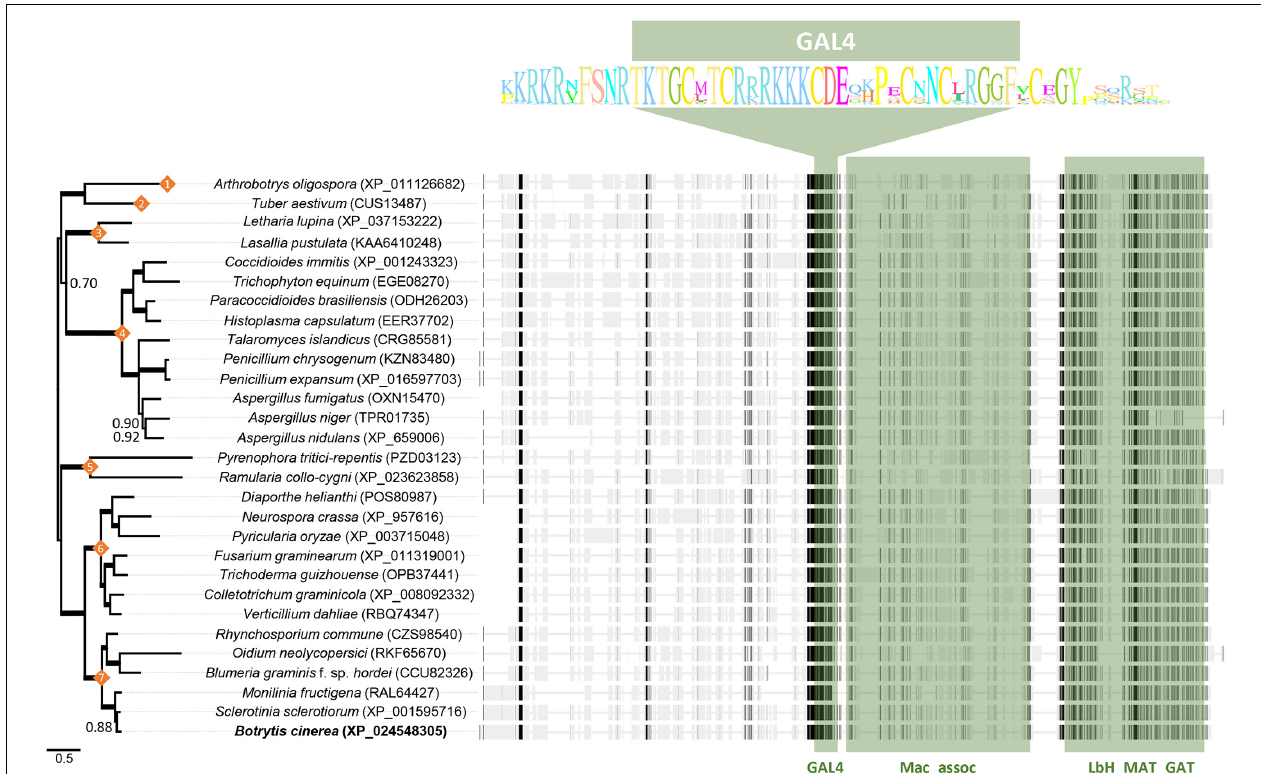
FIGURE 8 | Alignment and phylogenetic tree of representative selected sequences from Pezizomycotina species detected by BLAST analysis with the Bcin04g03490 encoded protein. Numbers on nodes indicate the taxonomic class of the selected species: (1) Orbiliomycetes; (2) Pezizomycetes; (3) Lecanoromycetes; (4) Eurotiomycetes; (5) Dothideomycetes; (6) Sordariomycetes; (7) Leotiomycetes. Bayesian posterior probability (BPP) values (above 0.50) are reported next to the nodes while thicker branches indicate BPP values of 1. On the right of each species name the sequence is presented as a discontinuous thick line. Thin segments represent gaps introduced to allow optimal alignment between regions represented as thick segments in which similar residues are marked in dark gray. The regions where the GAL4, Mac_assoc and LbH_MAT_GAT domains are located are shown in green. The highly conserved residues of the GAL4-like domain in the proteins analyzed are displayed as sequence